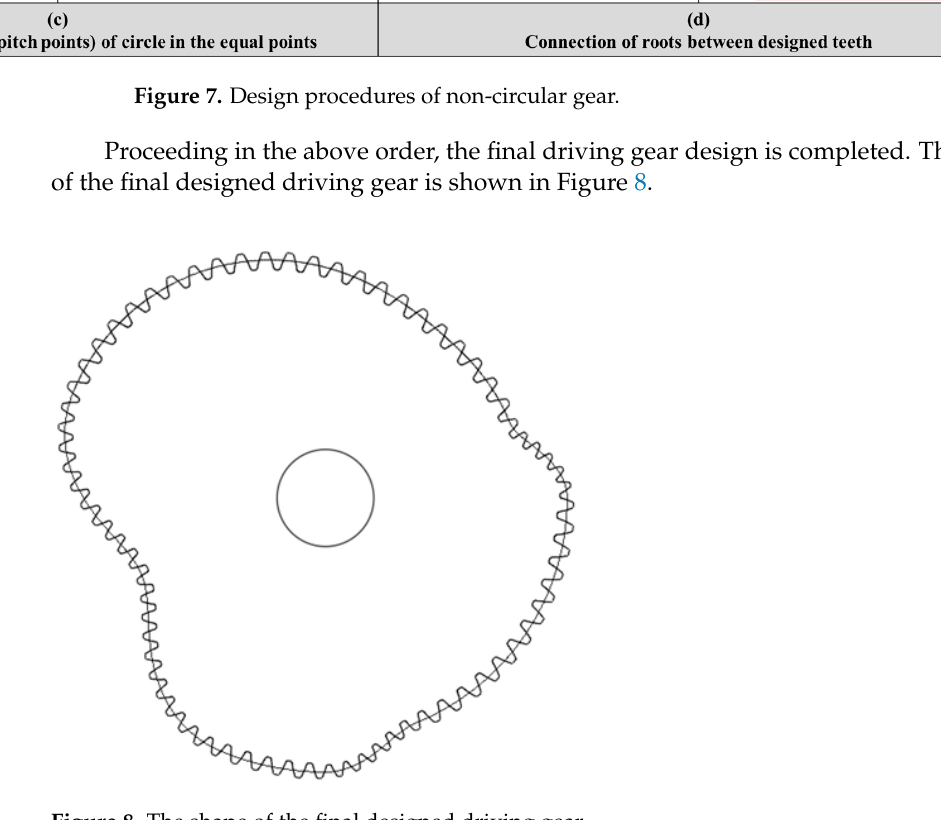
Figure 7. Design procedures of non-circular gear.